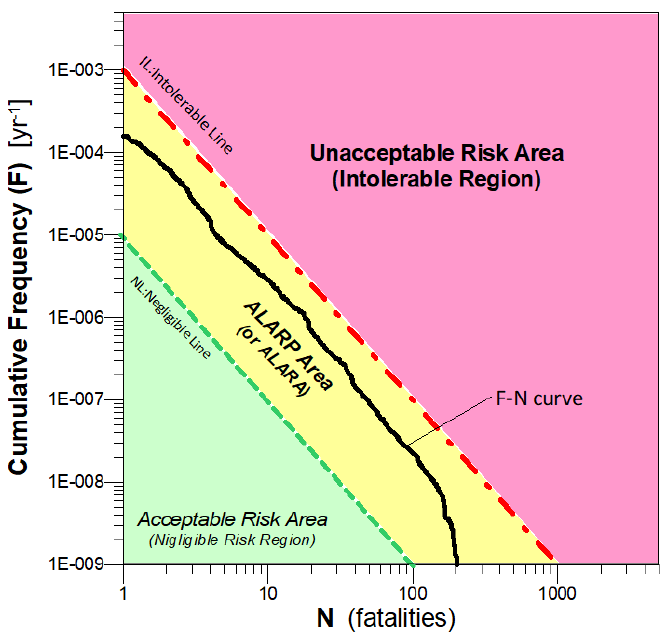
Figure 3. An instance of an F-N diagram according with the illustration of the required RAC curves, with reference to S-R (adapted from the work of Marhavilas and Koulouriotis, 2012) [29].